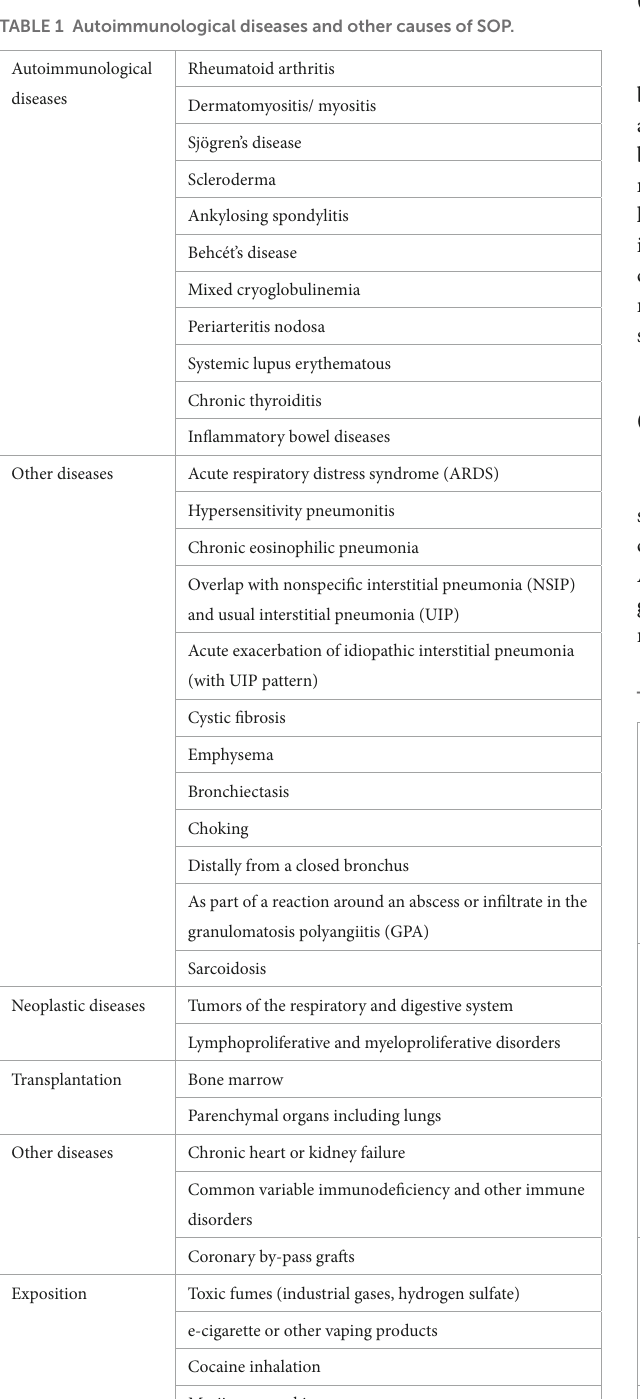
TABLE 1 Autoimmunological diseases and other causes of SOP.